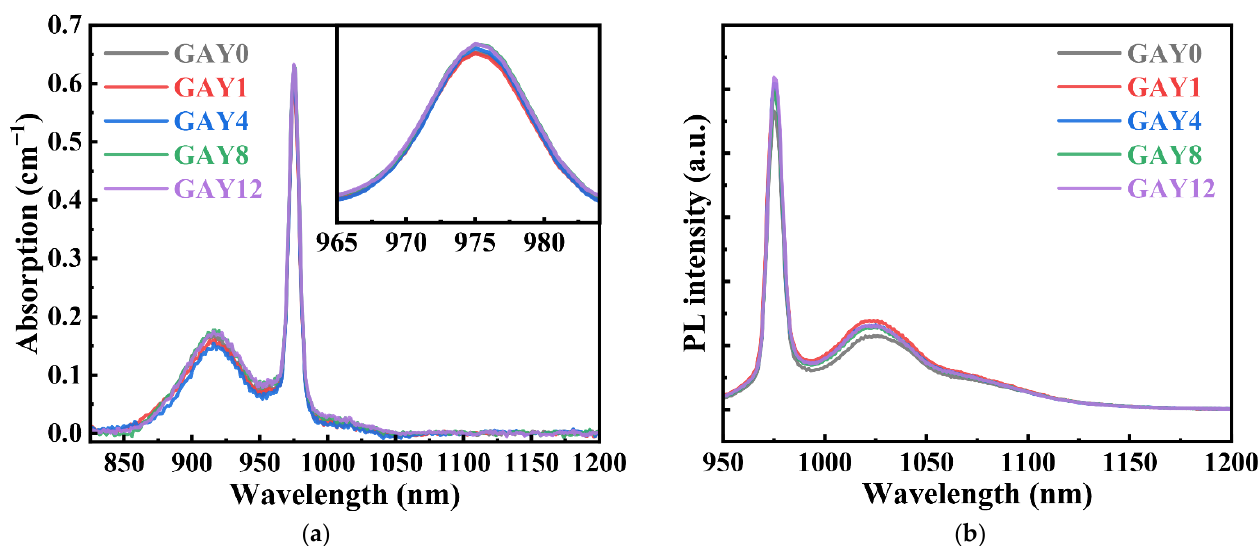
Figure 4. ( a ) Absorption spectra, (inset: enlargement in the range of 965–984 nm), ( b ) Fluorescence spectra of pristine GAY samples.